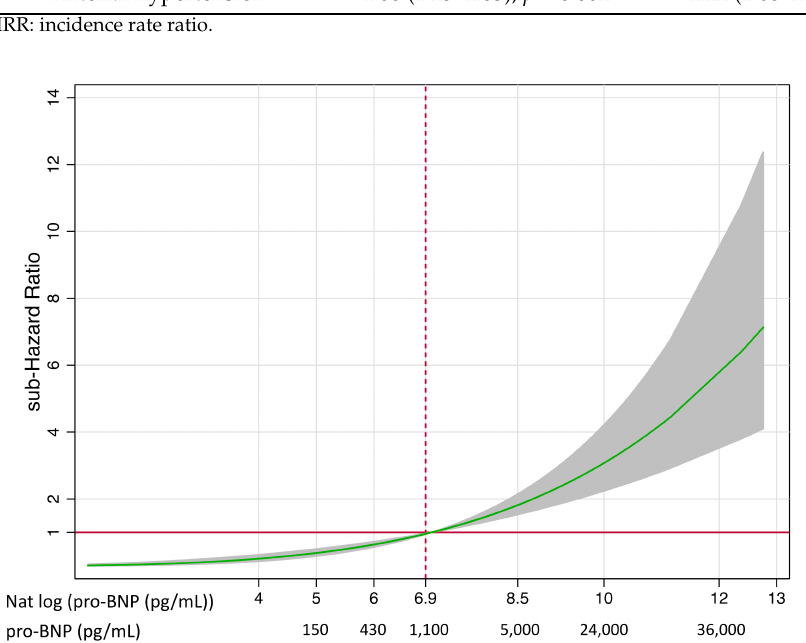
Figure 2. Relative sub-hazard risk of readmission for heart failure according to pro-BNP levels.